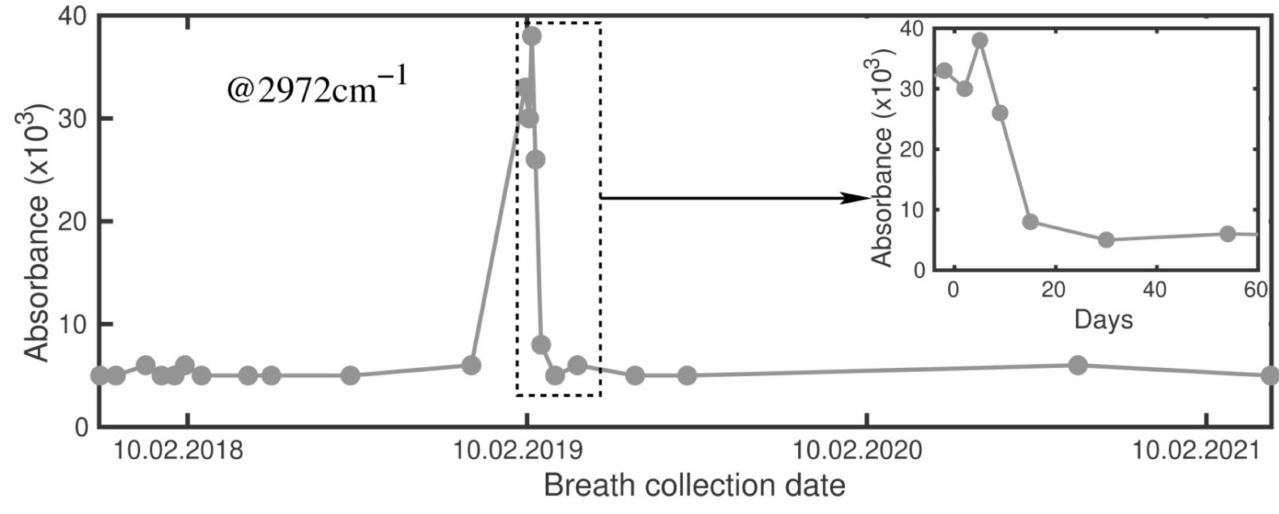
Figure 2. Variation of the absorbance centered at 2972 cm − 1 during a period of 3.5 years, with the peak related to accute gastritis and QAC. Inset: the recovering dynamics via